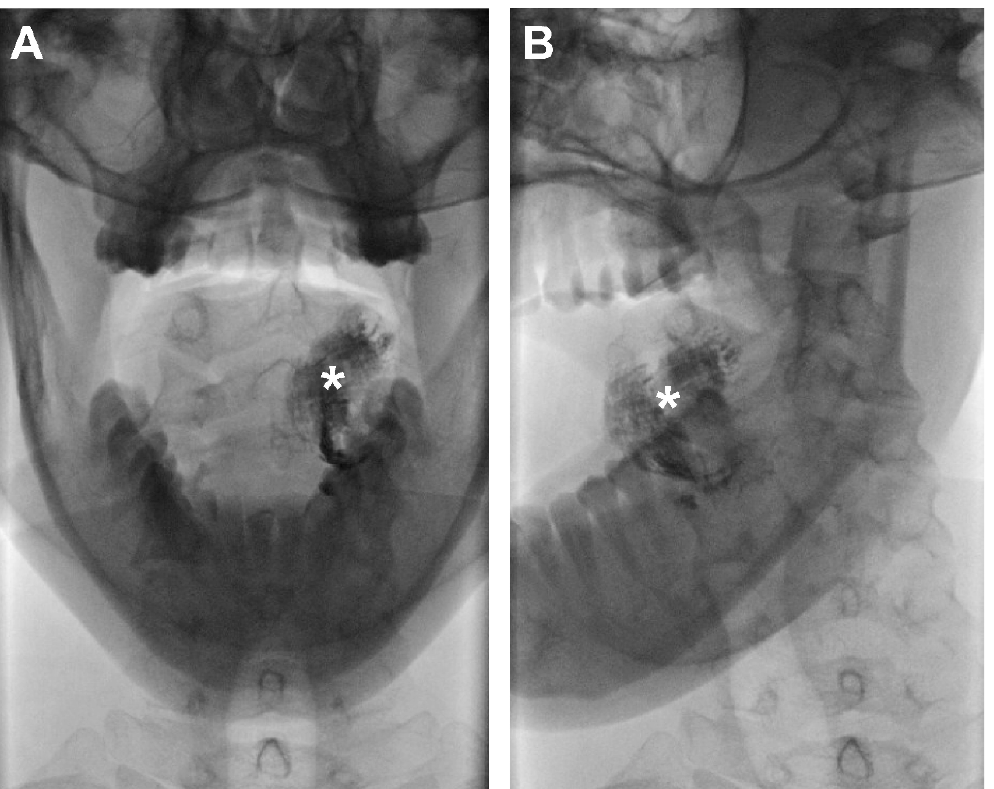
Figure 2. Contrast-inverted dynamic X-ray images acquired 10 min following peritumoral injection of Lipiodol ® in a patient with cT1N0 OSCC on the left side of the oral tongue (patient 6). No lymphatic drainage of Lipiodol ® was observed with dynamic X-ray. ( A ) Anterior–posterior odontoid projection; ( B ) anterior–oblique odontoid projection; (*) injection site.